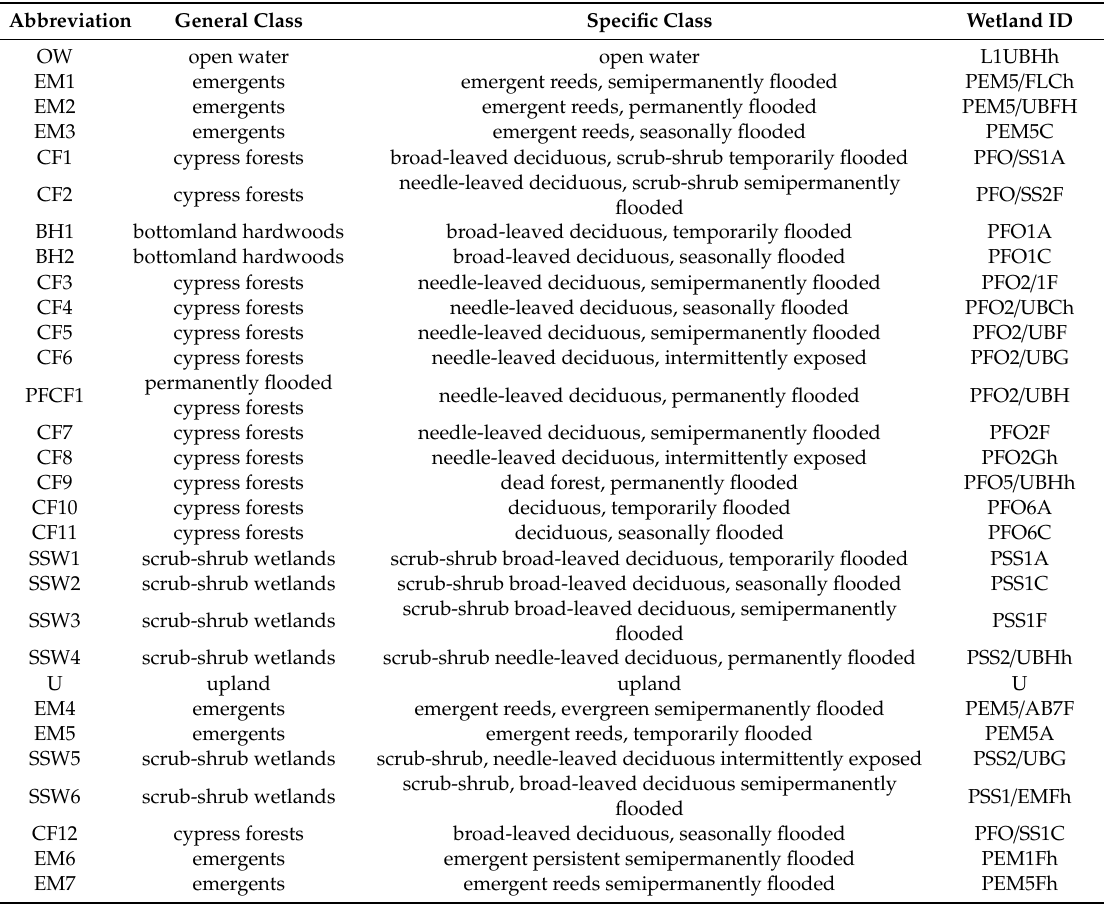
Table 1. Landcover classification abbreviations used in this study. General and specific classes and the wetland ID follow conventions found in